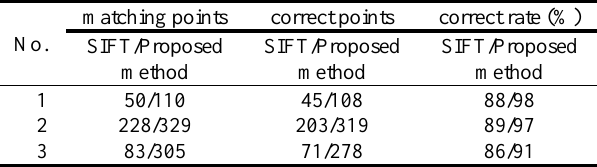
Table 1. Result of traditional SIFT algorithm and proposed